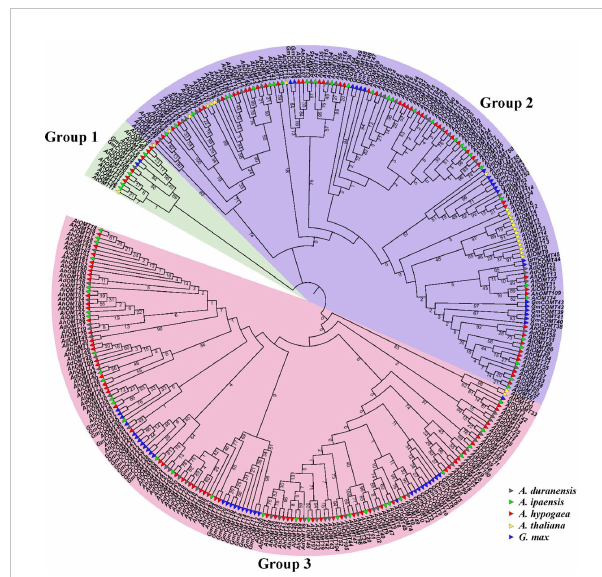
FIGURE 1 Phylogenetic relationships of O-Methyltransferase genes of